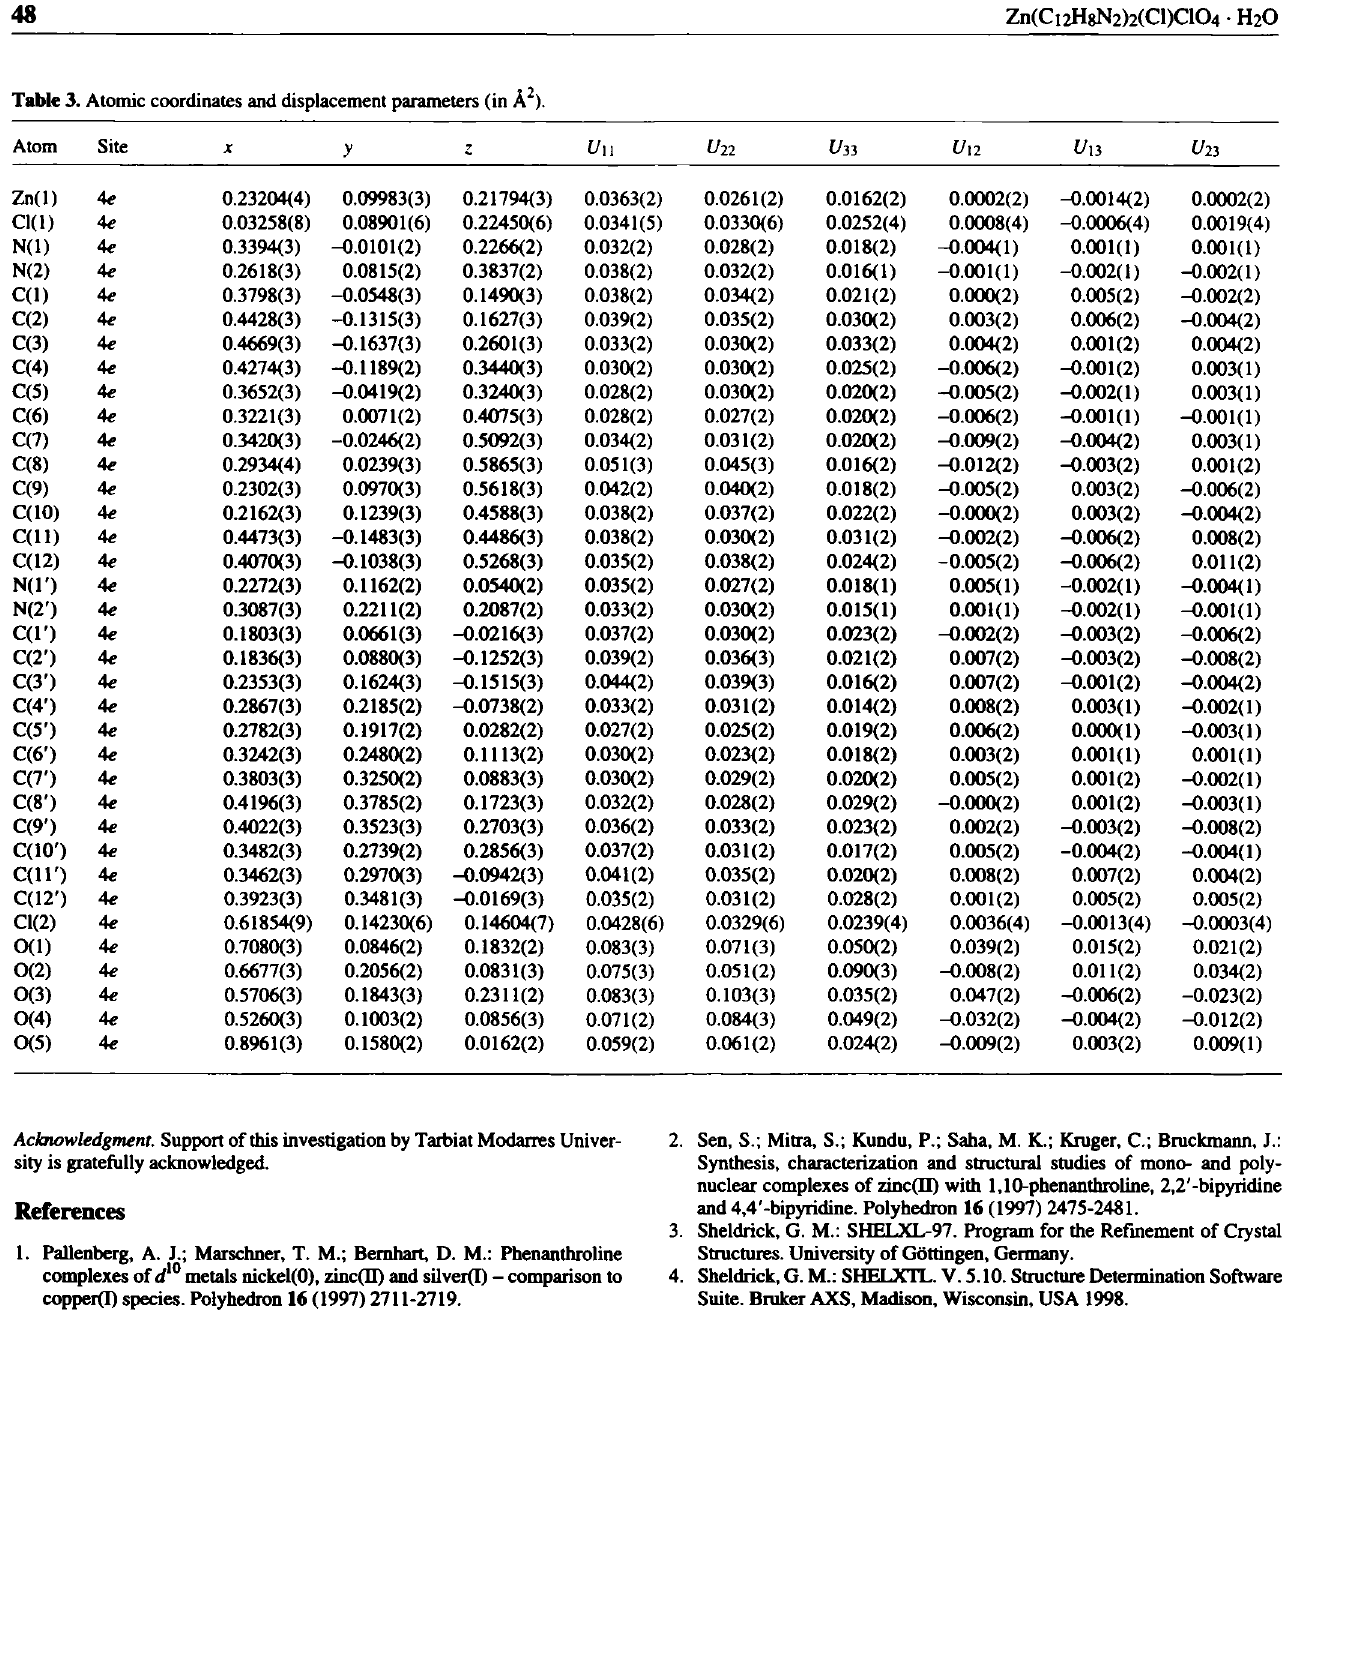
Table 3. Atomic coordinates and displacement parameters (in A 2